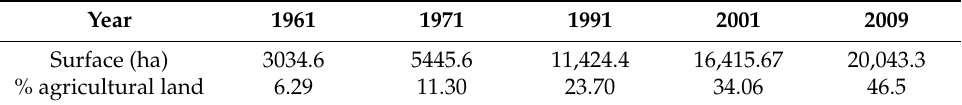
Table 4. Evolution of irrigated agricultural land in